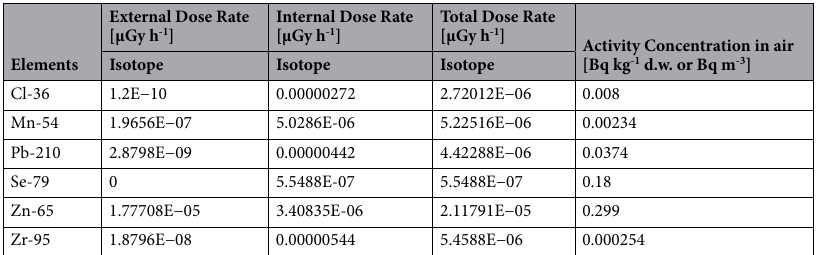
Table 7. Inhaled dose rate of radionuclide deposition in the human lungs.